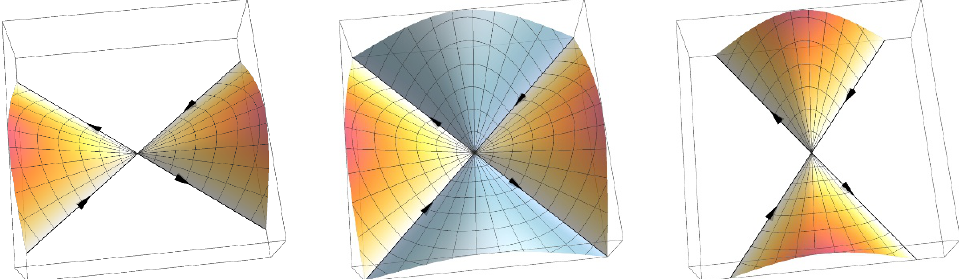
Figure 5 . Sketch of the minimal surfaces and phase transition for two cusped lines intersecting at the angles 3 (cid:25)= 8, (cid:25)= 2 and 5 (cid:25)=